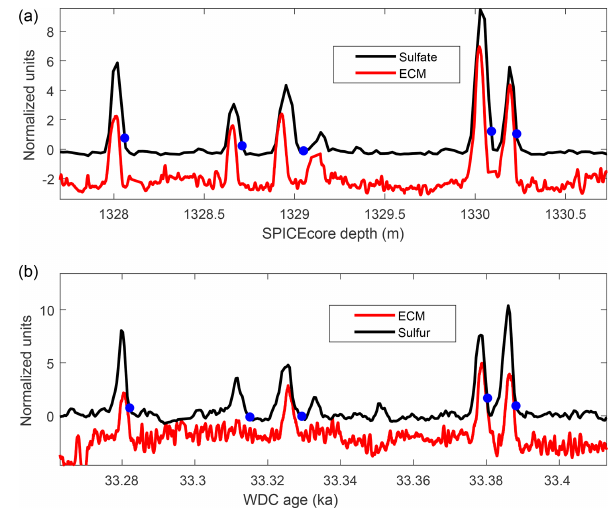
Figure 5. An example of volcanic matching between SPICEcore (a) and WAIS Divide (b) . Sulfate (black) and electrical conduc- tivity (ECM; red) are shown for both ice cores. Here, five events are shown that link specific depths in SPICEcore to known ages in WAIS Divide. The position of the tie points is chosen at the begin- ning of the event (blue circles). The y axis values are scaled for ease of visualization and do not indicate absolute measurement